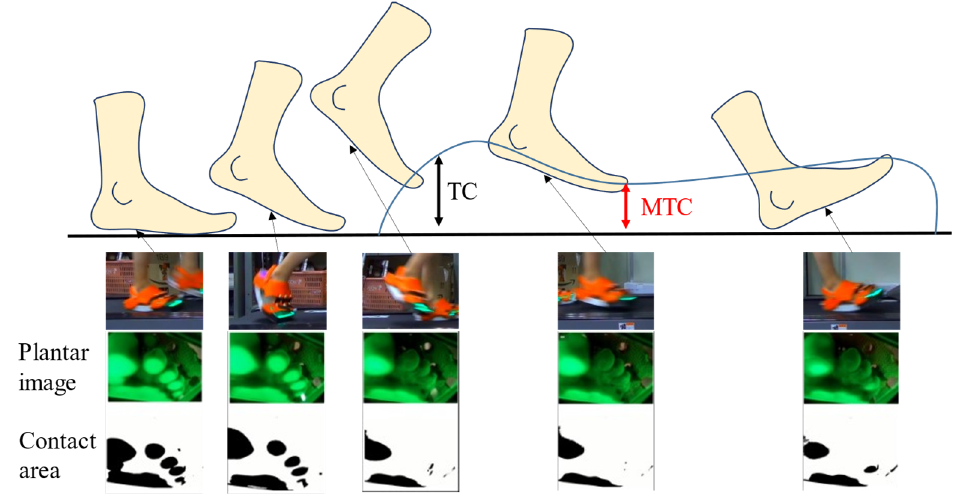
Figure 4. Toe clearance, minimum toe clearance, observed plantar image, and extracted contact area.